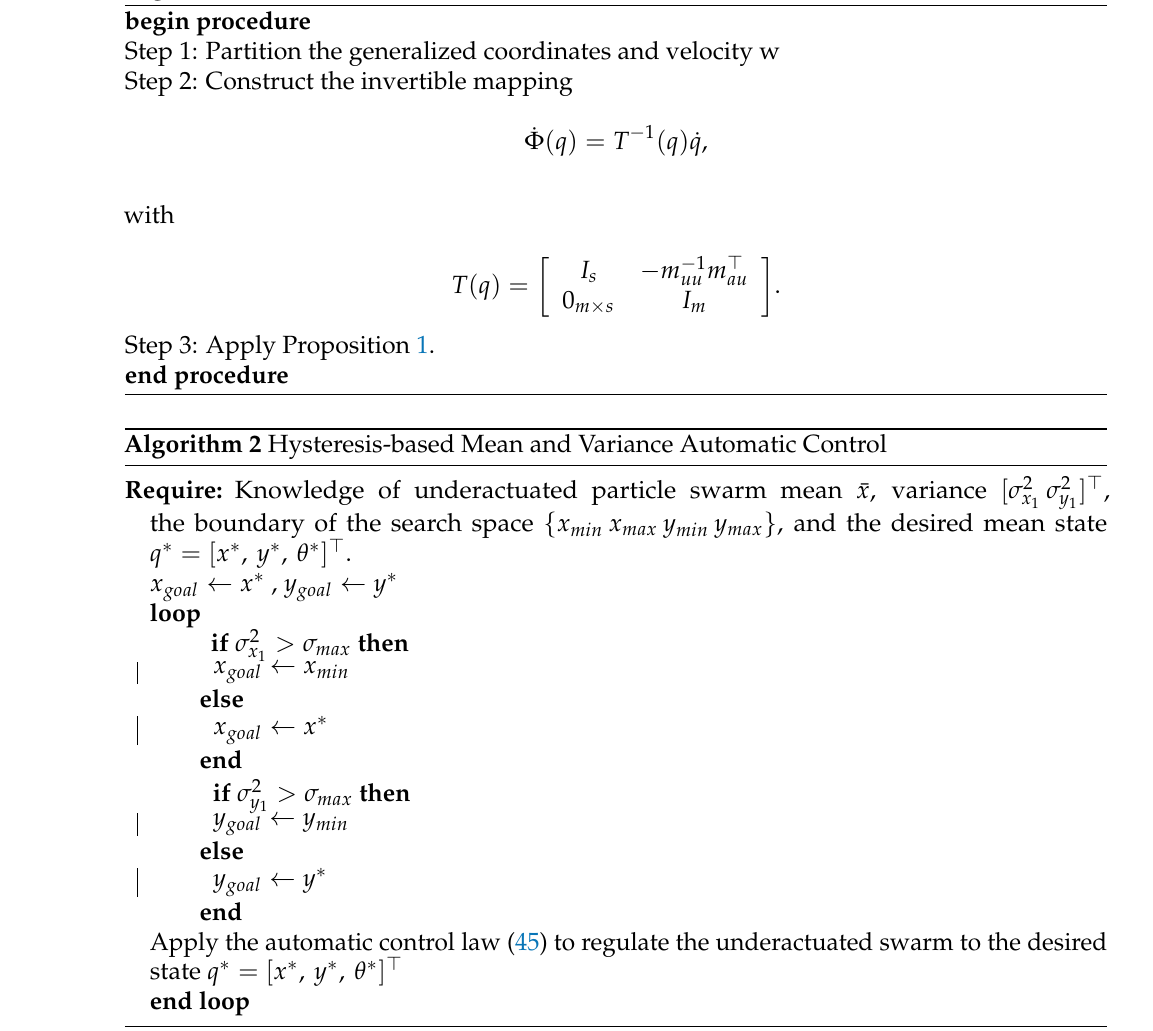
Algorithm 1 Generalised Coordinate Transformation for Underactuated Particle (27).